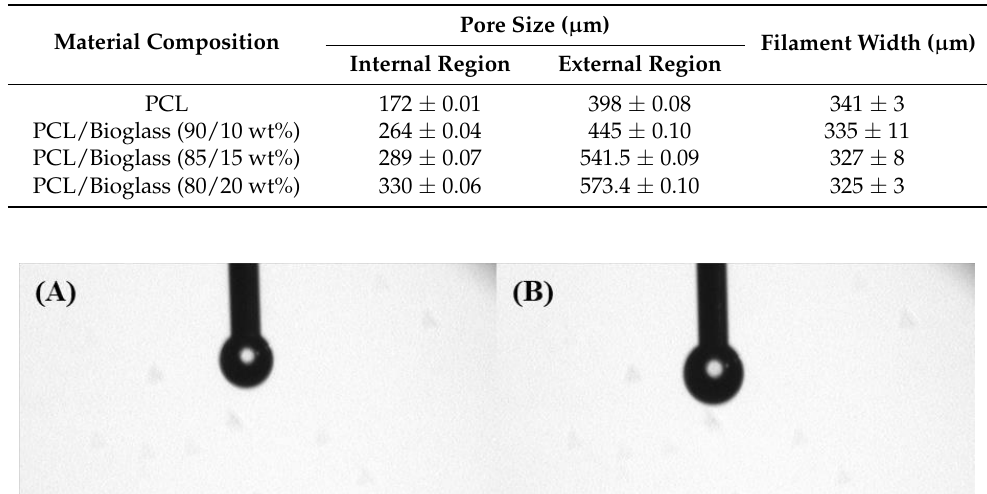
Table 1. The geometric characteristics of the scaffolds.